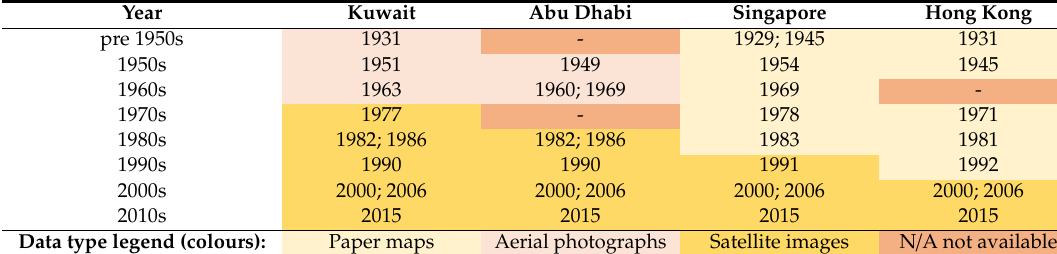
Table A1. Mapping sources by data type.